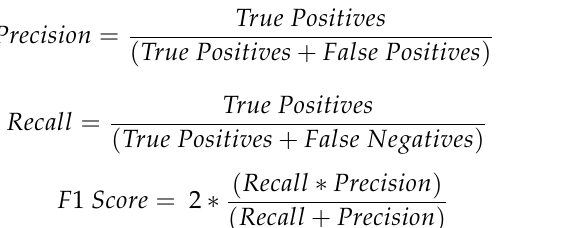
Figure 5. The LSTM model